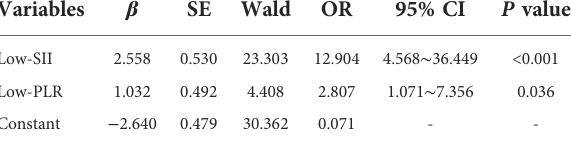
TABLE 4 Multivariate logistic regression analysis for surgical